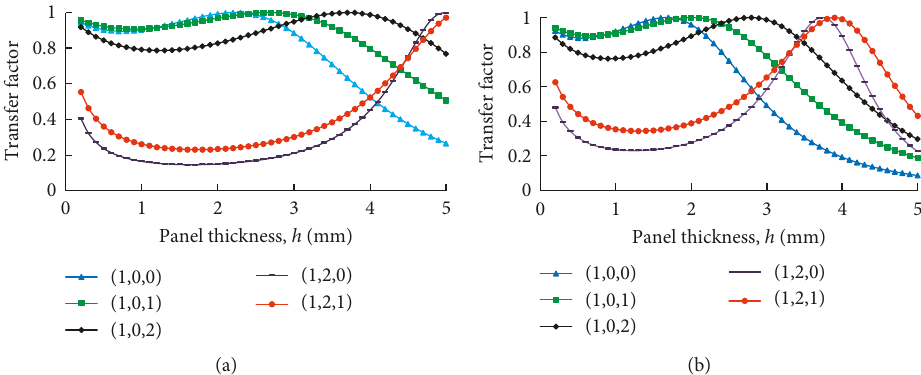
Figure 5: Effect of panel thickness on the coupling property of the panel-enclosure coupled system with different panel boundary conditions: panel mode (2,1). (a) Simply supported panel mode (2,1). (b) Clamped panel mode (2,1).